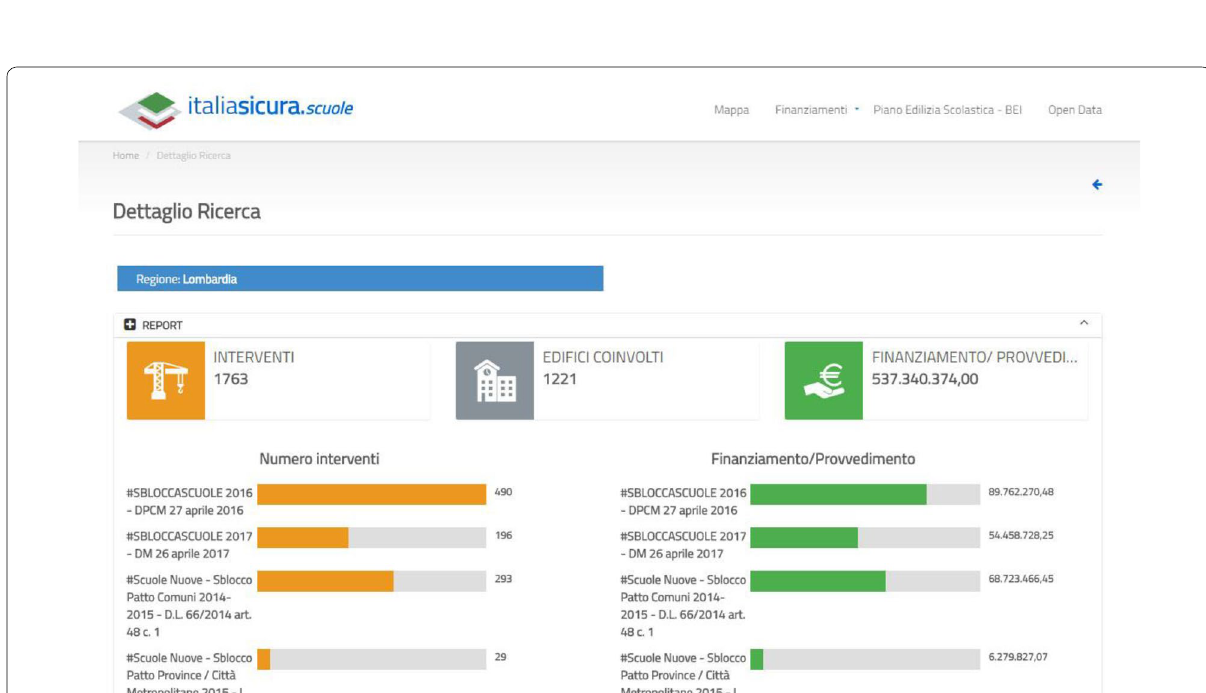
Fig. 6 Funded project in Lombardia. (Source: Governo. ItaliaSicura Scuole. http://www.canti erisc uole.it Accessed 10 January 2018, the site has not been updated since the SMES closure, since January 2019 no longer available